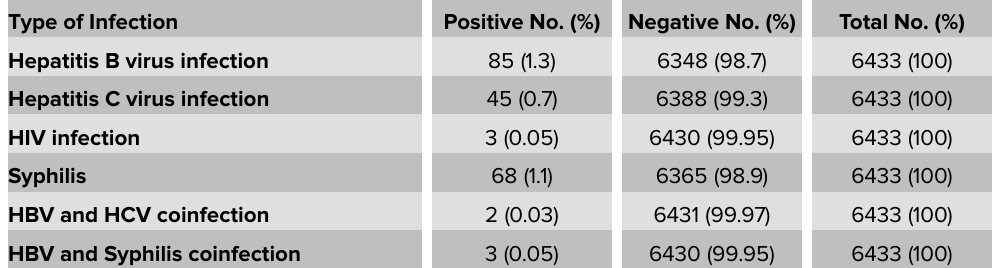
TABLE 1: Prevalence of transfusion transmissible infections among healthy blood donors in Dongola Specialized Hospital, 2010–2015 Type of Infection Positive No. (%) Negative No. (%) Total No. (%) Hepatitis B virus